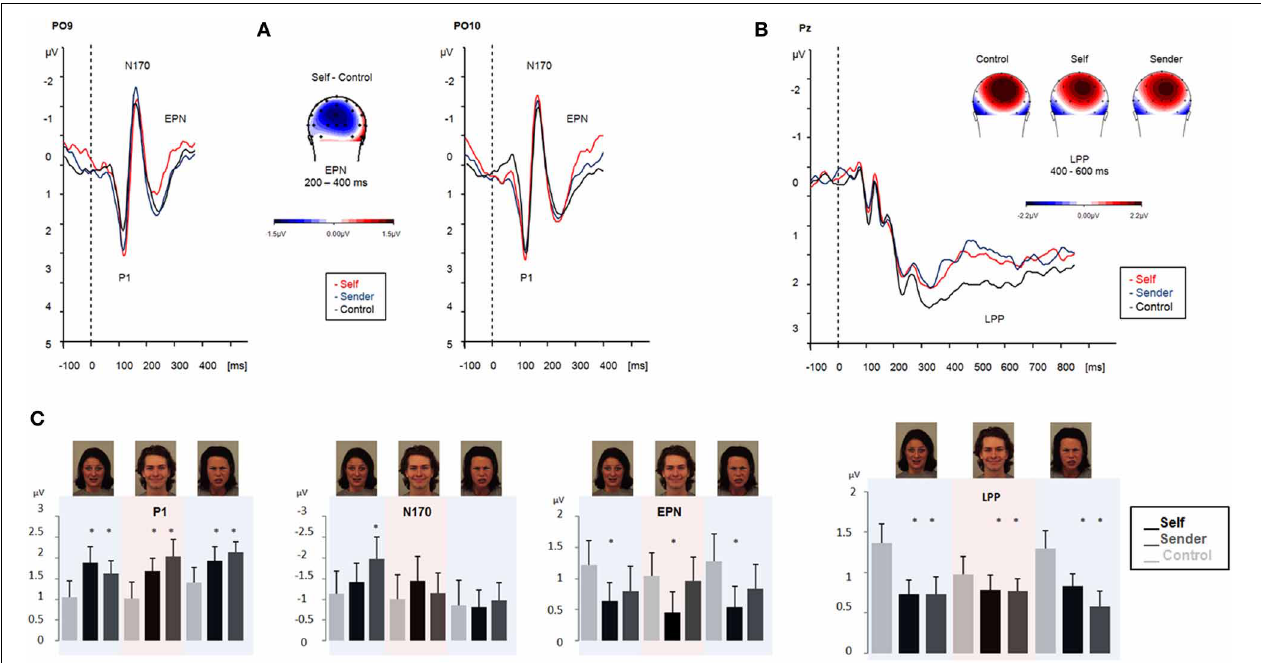
FIGURE 2 | ERPs obtained during emotional face processing in experiment 1. ERPs are collapsed across angry, fearful, and happy faces and contrasted with passive viewing of emotional faces (black line). Upper left panel (A) displays ERP modulation patterns in the early time-windows (P1, N170, and EPN, respectively). Upper right panel (B) displays amplitudes in the